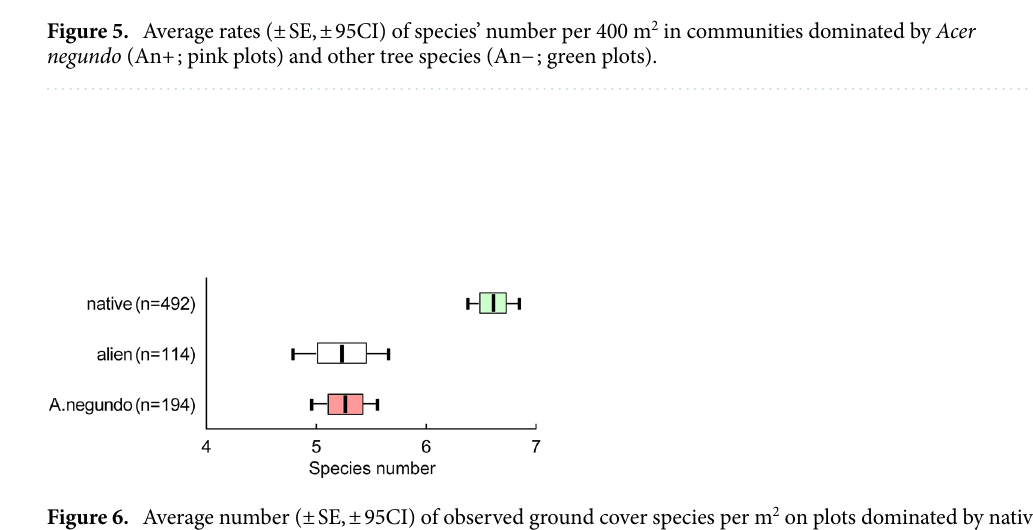
Figure 6. Average number (± SE, ± 95CI) of observed ground cover species per m 2 on plots dominated by native (green plots), alien, excluding Acer negundo (white plots) species, and individually—on plots dominated by Acer negundo (pink